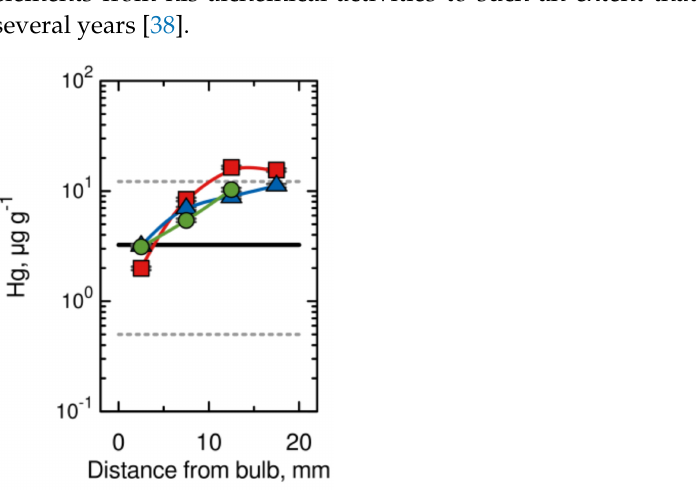
Figure 6. Hg content in three samples of Brahe’s hair (distinguished by different symbols), 10 mm of hair represents approximately 1 month of life (modified from